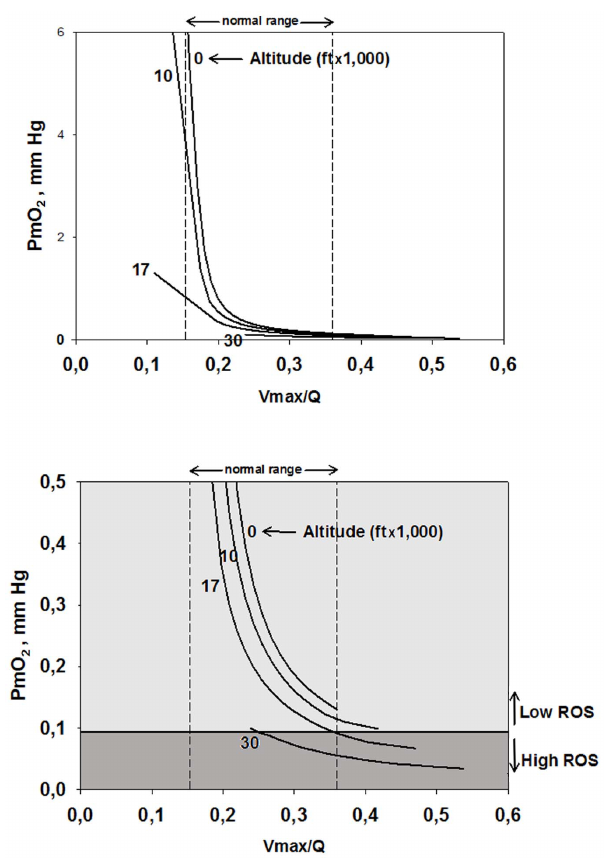
Figure 4. Mitochondrial Po 2 ( Pm O ) as a function of regional 2 ratios of metabolic capacity ( _ VV max ) to blood flow ( _ QQ ) at four altitudes. The lower _ QQ (supply) is in relation to _ VV max (demand), the at any altitude; also, Pm O at any _ VV max (cid:4) _ QQ ratio falls lower is Pm O 2 2 with increasing altitude. Vertical dashed lines mark the normal range of _ VV max (cid:4) _ QQ . Both panels show the same data, but the lower panel expands the y-axis in its lower range to show when ROS generation is v 0 : 1 mm Hg ). Below 17,000ft, ROS generation high (i.e., when Pm O 2 remains low, but above this altitude, regions of normal muscle with high _ VV max (cid:4) _ QQ ratio generate high ROS levels, until at the Everest summit, almost the entire muscle generates high ROS levels.